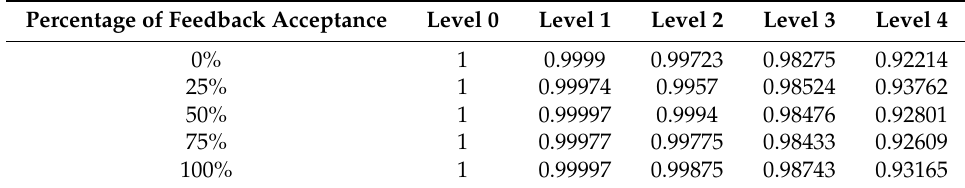
Table 8. User trust levels concerning autonomy when there is a high error rate at the lower level and the user is cautious.